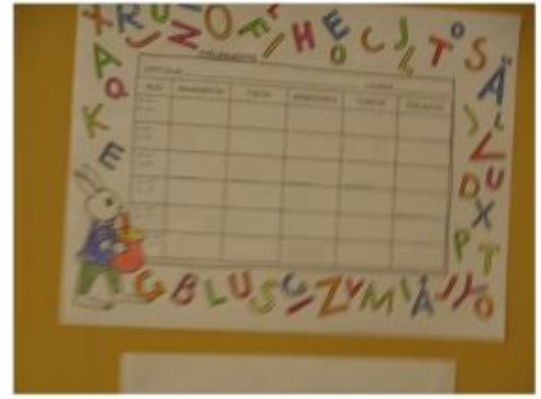
Figure 7. I don’t have any influence on what we do in school. Extract